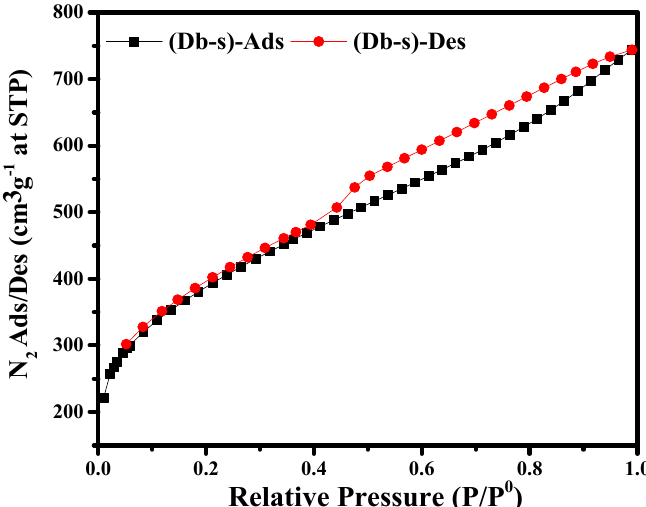
Figure 5. N 2 adsorption/desorption isotherms of AC (Db-s) at 77 K. However, at around P/P 0 = 0.4, the amount of nitrogen uptake increased significantly, showing a hysteresis loop during the adsorption and desorption of nitrogen. The adsorp- tion volume of AC (Db-s) increased with the relative pressure until P/P 0 opened knees and the slight hysteresis loops at the relative pressure of 0.5 to 1.0